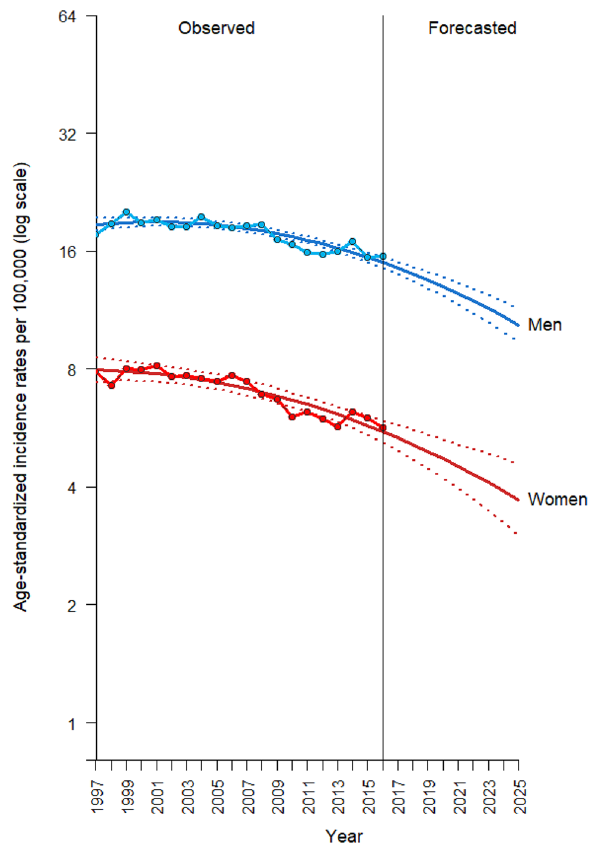
Figure 3. Age-standardized incidence rates of bladder cancer projections by the age–period–cohort model from 2017 to 2025 for men (blue) and women (red). The dotted line indicates 95% confidence intervals for the projections. The WHO’s 2000 World Standard Populations were used to compute the truncated age- standardized incidence rate (age range 25–85 +).